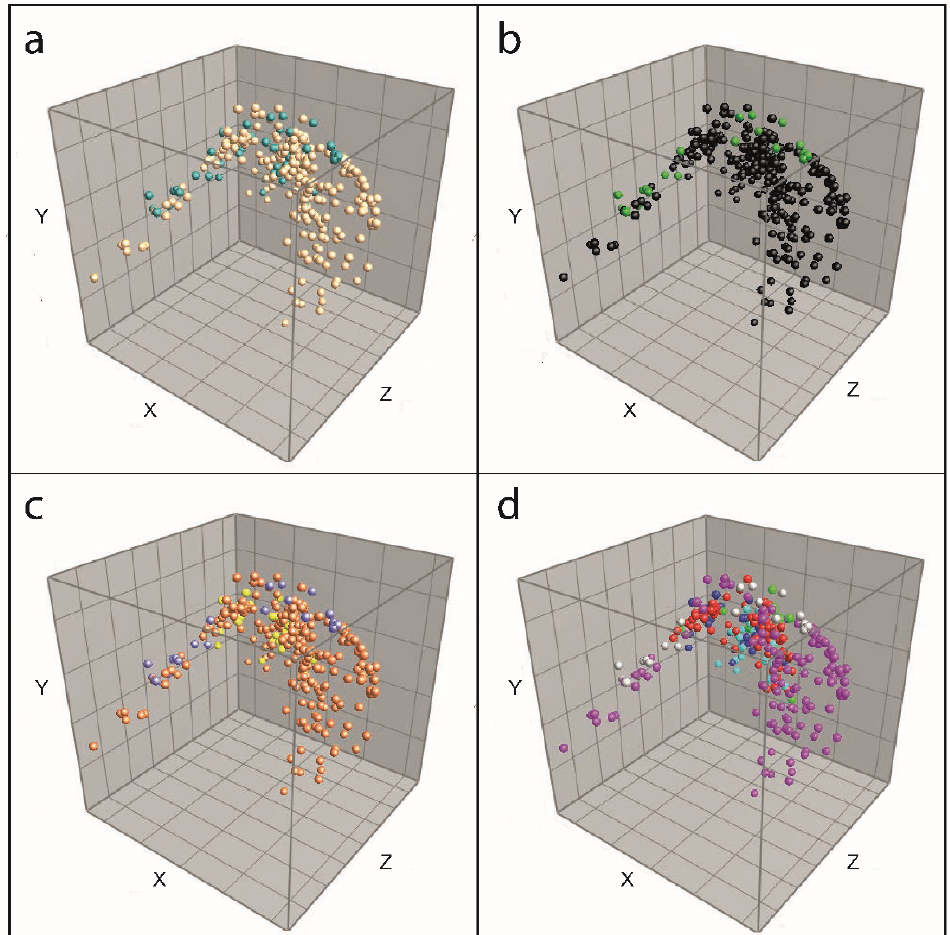
Figure 4. PCA of isolates in the training set. ( a ) Colored at genus level: beige = Shigella , teal = Escherichia ; ( b ) Colored at pathotype level: black = Shigella /EIEC, green = E. coli (other than EIEC); ( c ) Colored at group level: orange = Shigella spp., yellow = EIEC, purple = E. coli (other than EIEC); ( d ) Colored at species level: light blue = S. dysenteriae , red = S. flexneri , green = S. boydii , pink = S. sonnei , blue = EIEC, light grey = Other E. coli .